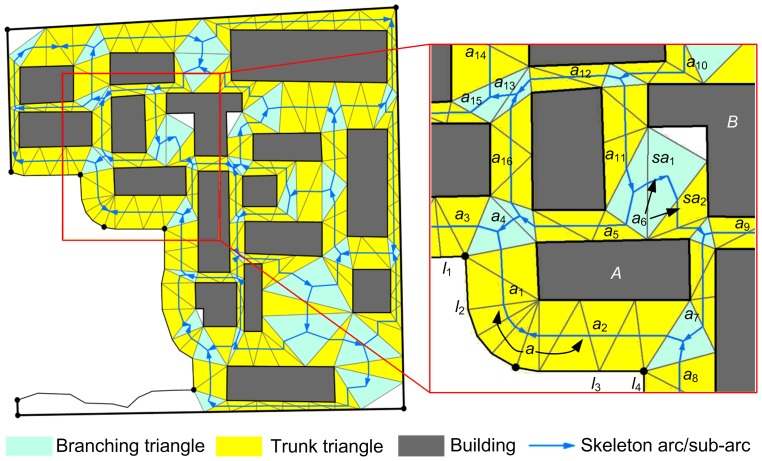
Extraction of the CDT skeleton.Extracted skeleton graph (left) in a map partition and detailed part (right) of the extracted skeleton graph to illustrate the concepts of skeleton arc, super-arc, and sub-arc.